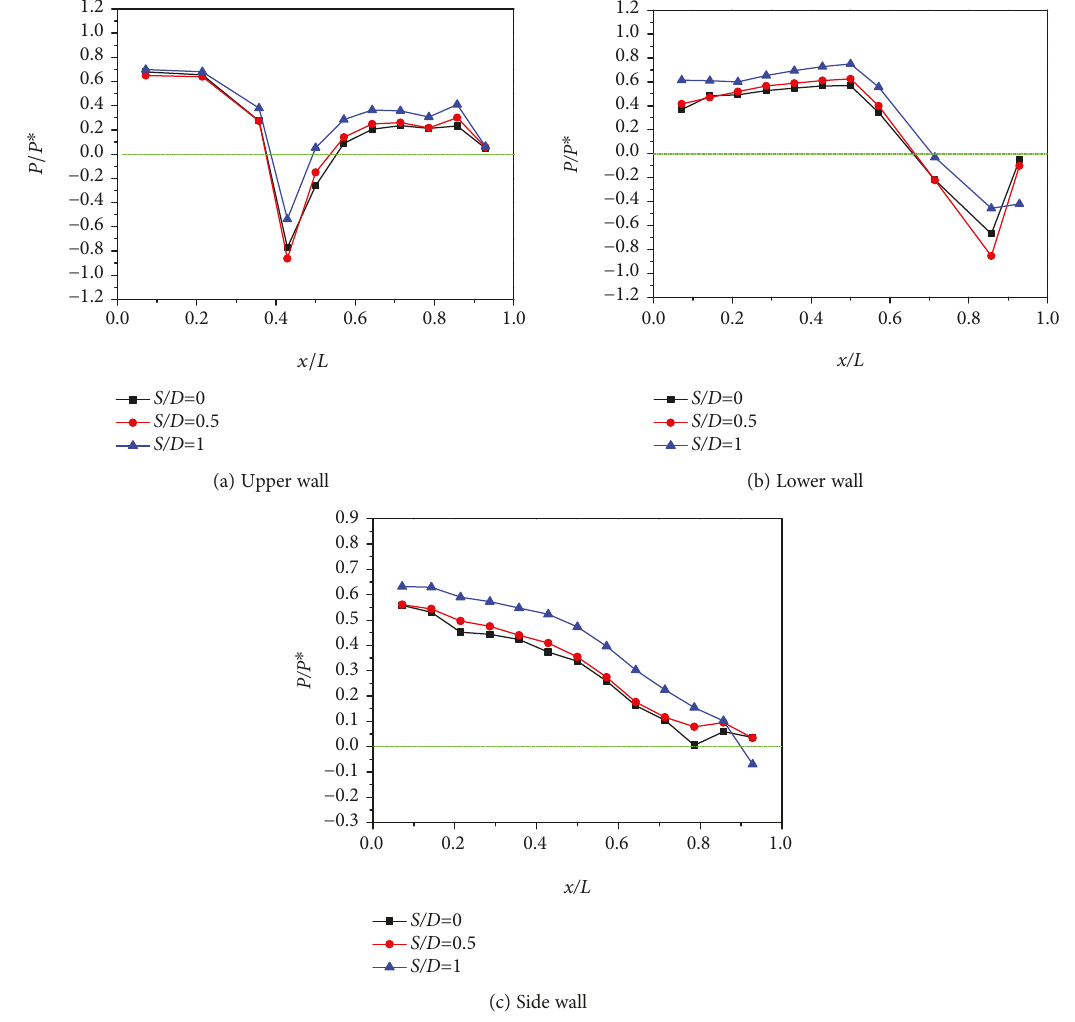
Figure 9: E ff ects of o ff set ratios on wall